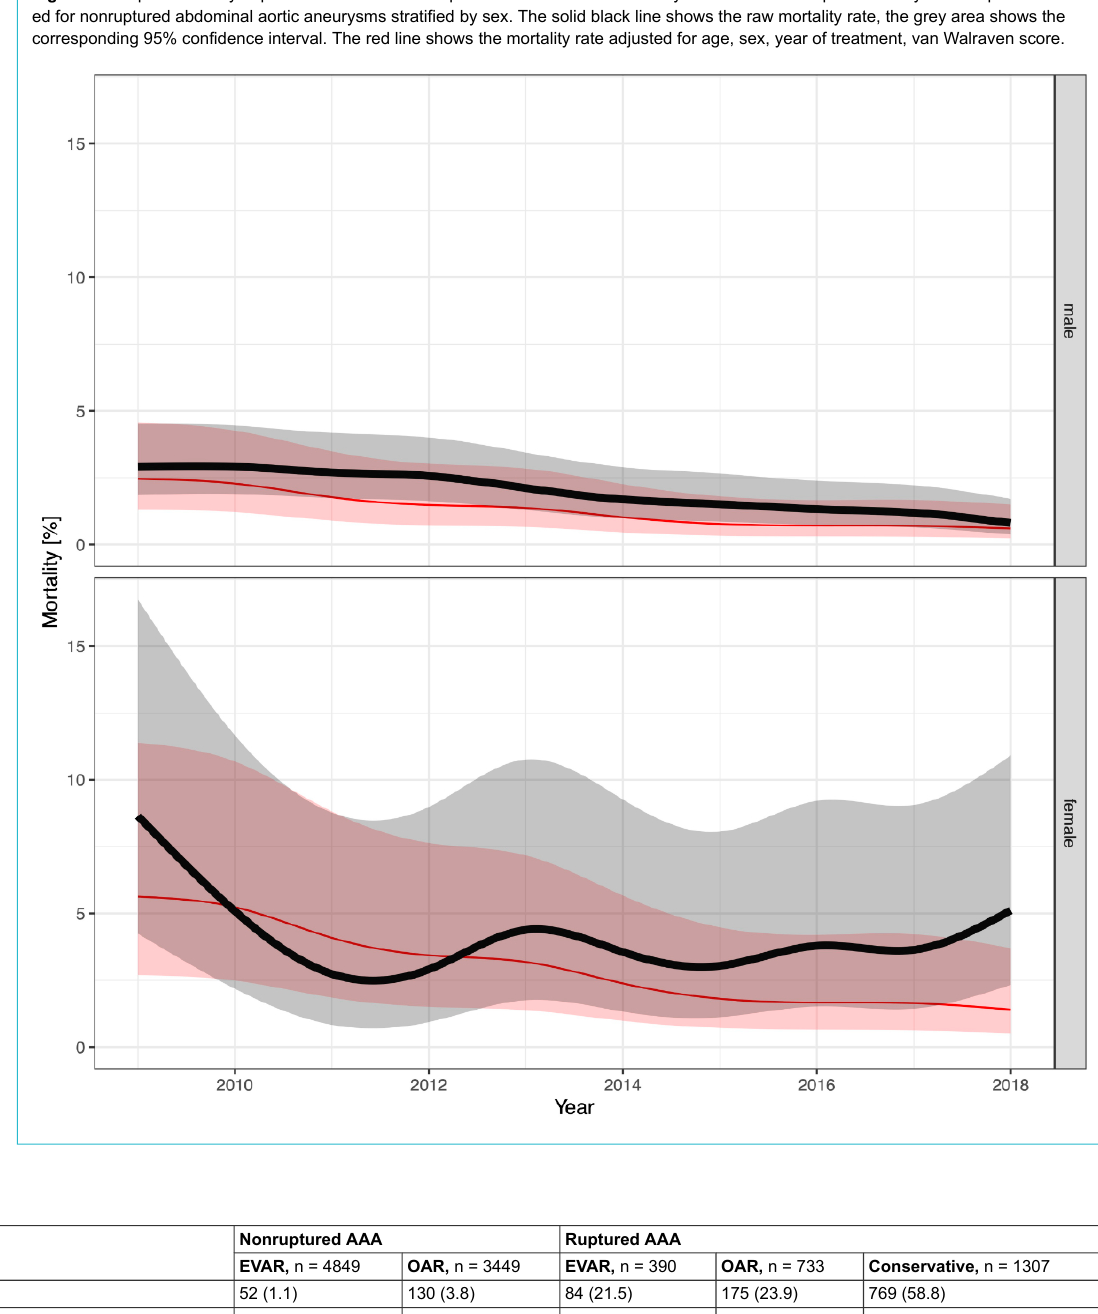
Figure 4: Hospital mortality of patients treated for nonruptured abdominal aortic aneurysm. Smoothed hospital mortality rates of patients treat- ed for nonruptured abdominal aortic aneurysms stratified by sex. The solid black line shows the raw mortality rate, the grey area shows the